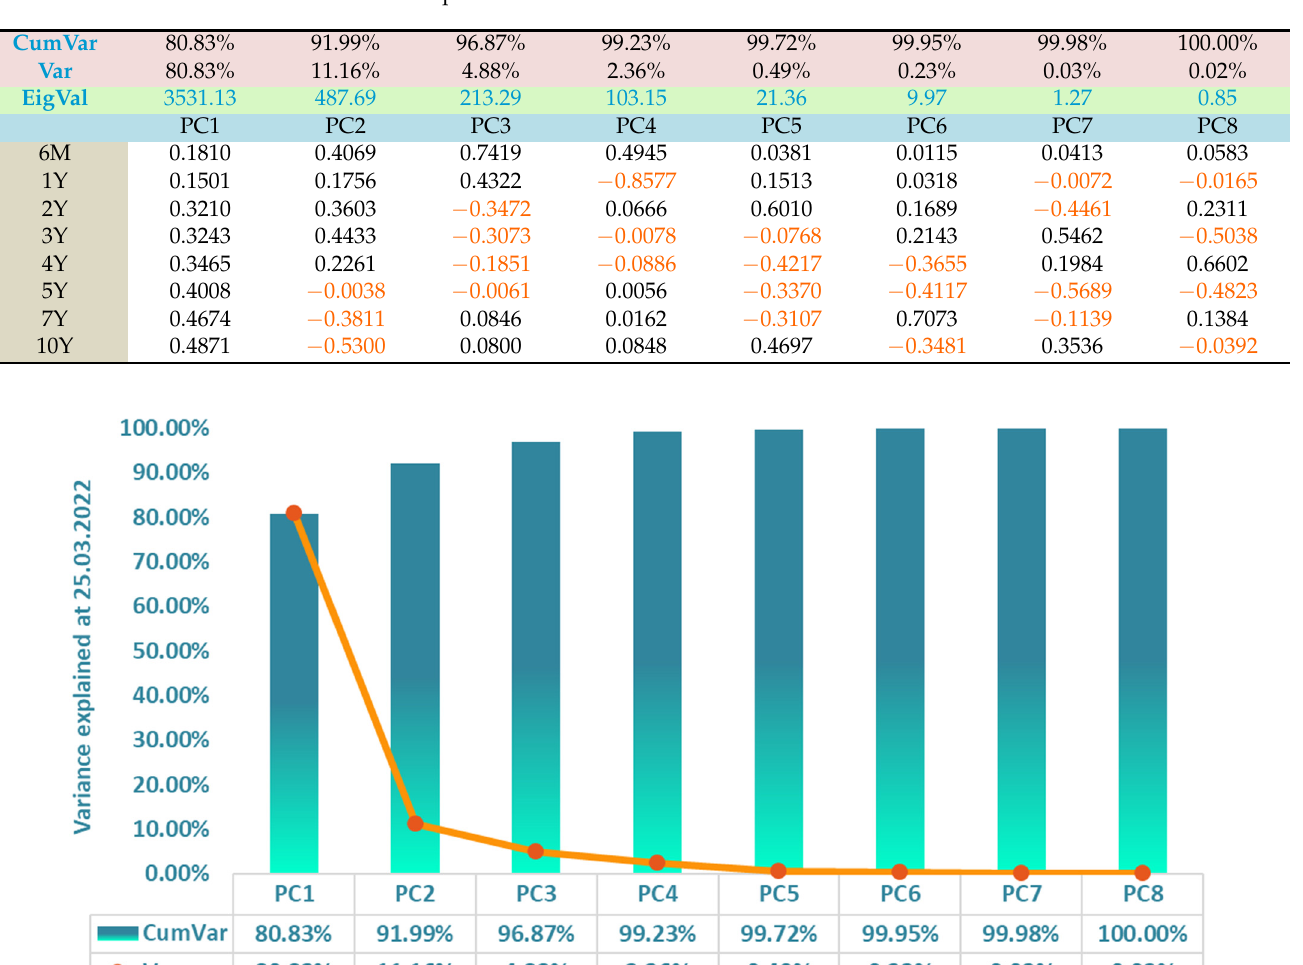
Figure 4. Factor loadings of the first three principal components on 25 March 2022. Source: Bloom- berg, own computation of PCs with the use of a VBA add-in developed by Leonardo Volpi. -0.6 -0.4